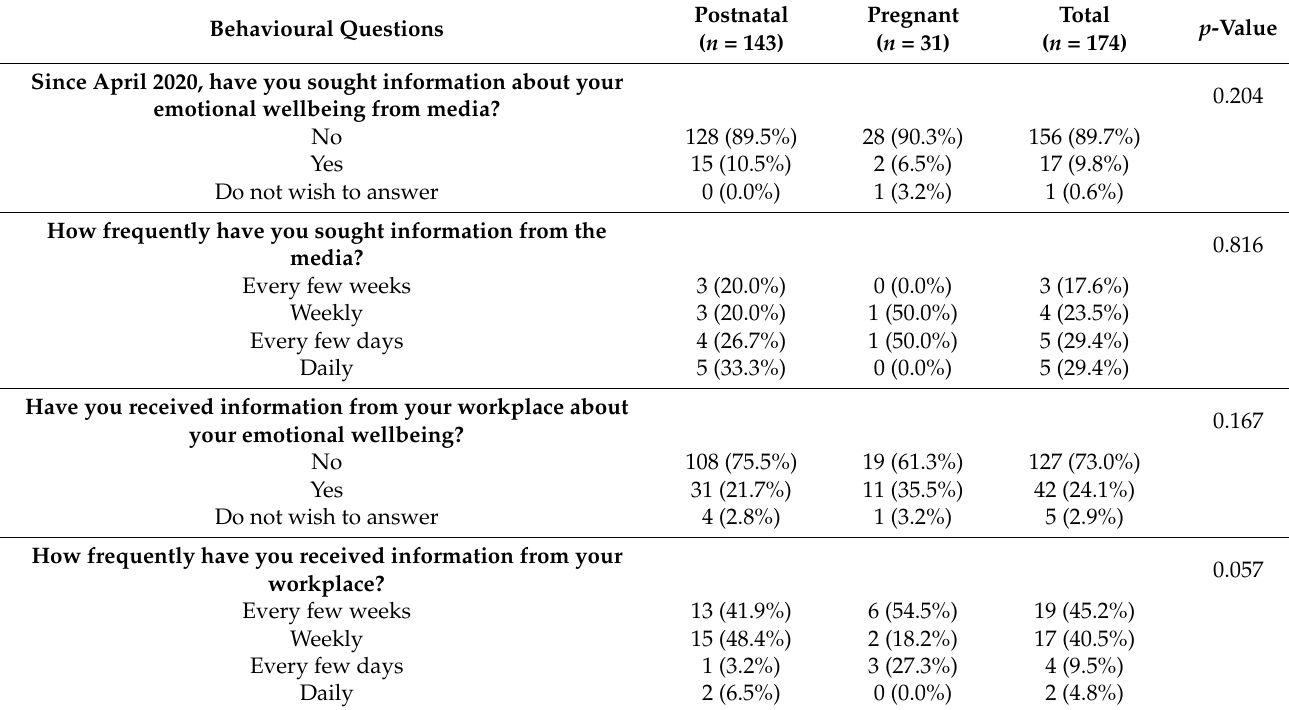
Table A2. Behavioural